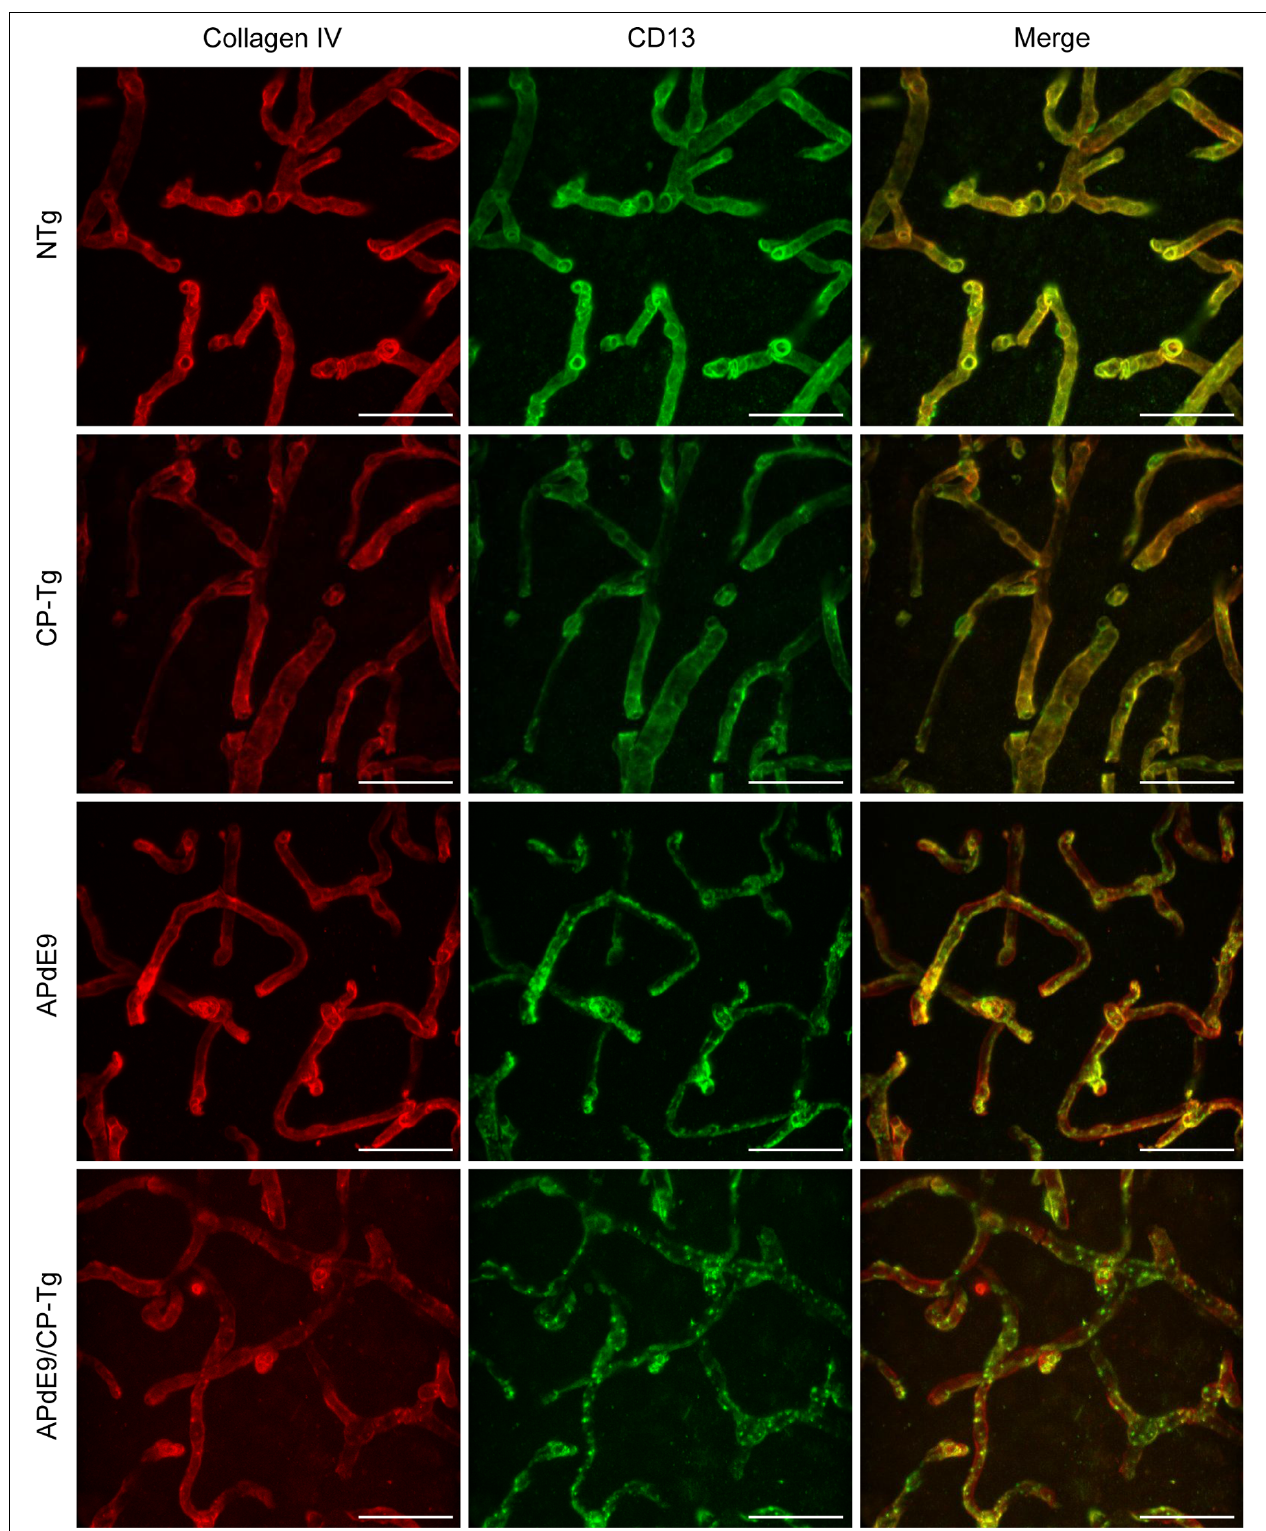
FIGURE 7 | Loss of continuous pericyte coverage in APdE9/CP-Tg mice. 100 × confocal image stacks of collagen IV-positive microvessels and CD13-positive pericytes from the cortex of 17 to 20-month-old NTg, CP-Tg, APdE9, and APdE9/CP-Tg mice. Scale bar = 30 µ m.